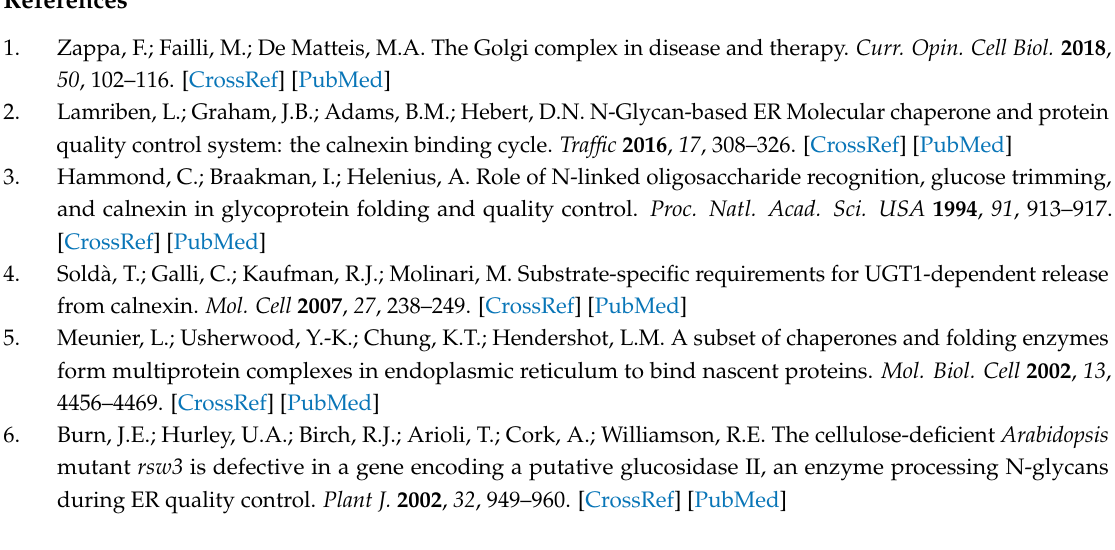
Figure S1: Effects of elicitors treatment on At Col0, Figure S2: Mapping of At UGGT mutants on a homology model, Table S1: Primers used in the qRT-PCR analysis showed in this work, Table S2: Known At ER α –Glu II mutants, Table S3: Known At UGGT